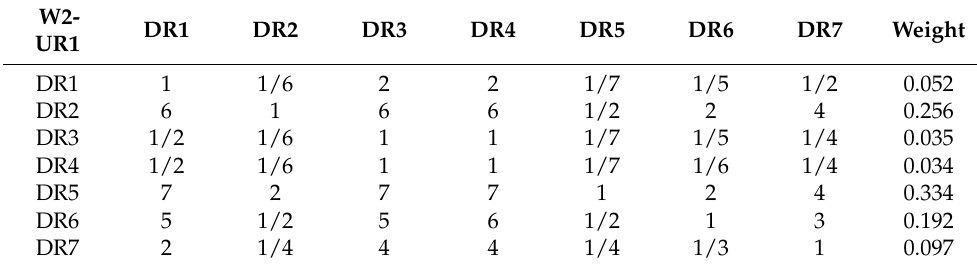
Table 8. Relative weights of DRs with respect to UR1 (W 2 ).